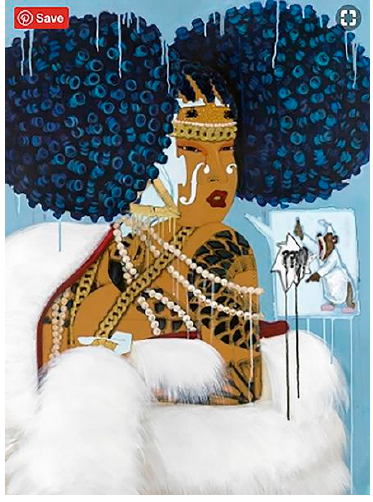
Figure 2. Rozeal. Untitled. 2016.